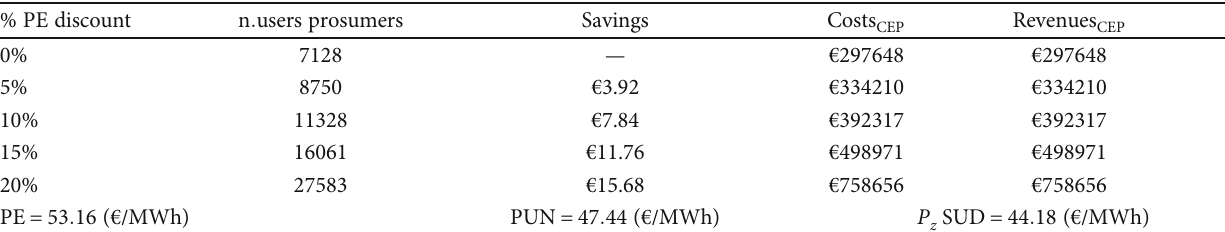
Table 14: Discount thresholds —